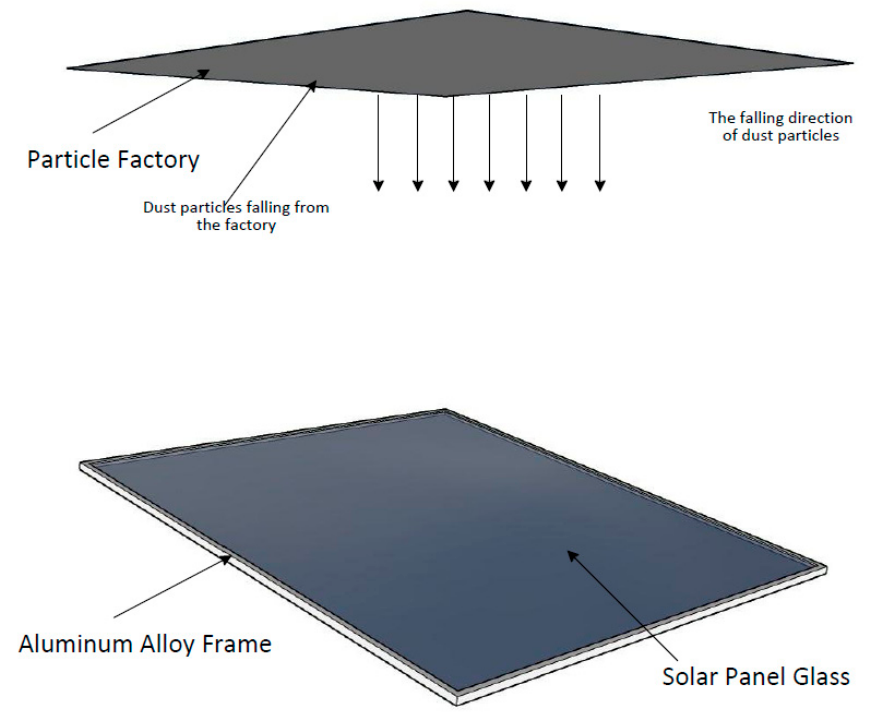
Figure 1. Dust accumulation on a solar panel. Table 3. Collision characteristic